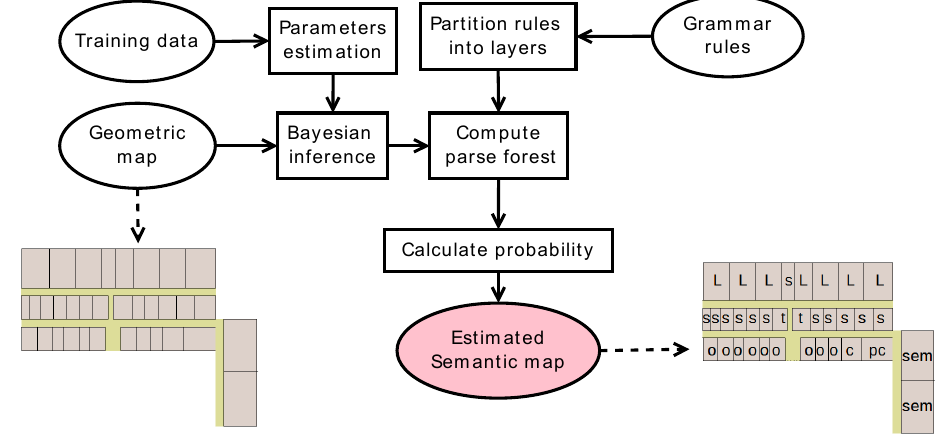
Figure 5. Workflow of proposed algorithm.